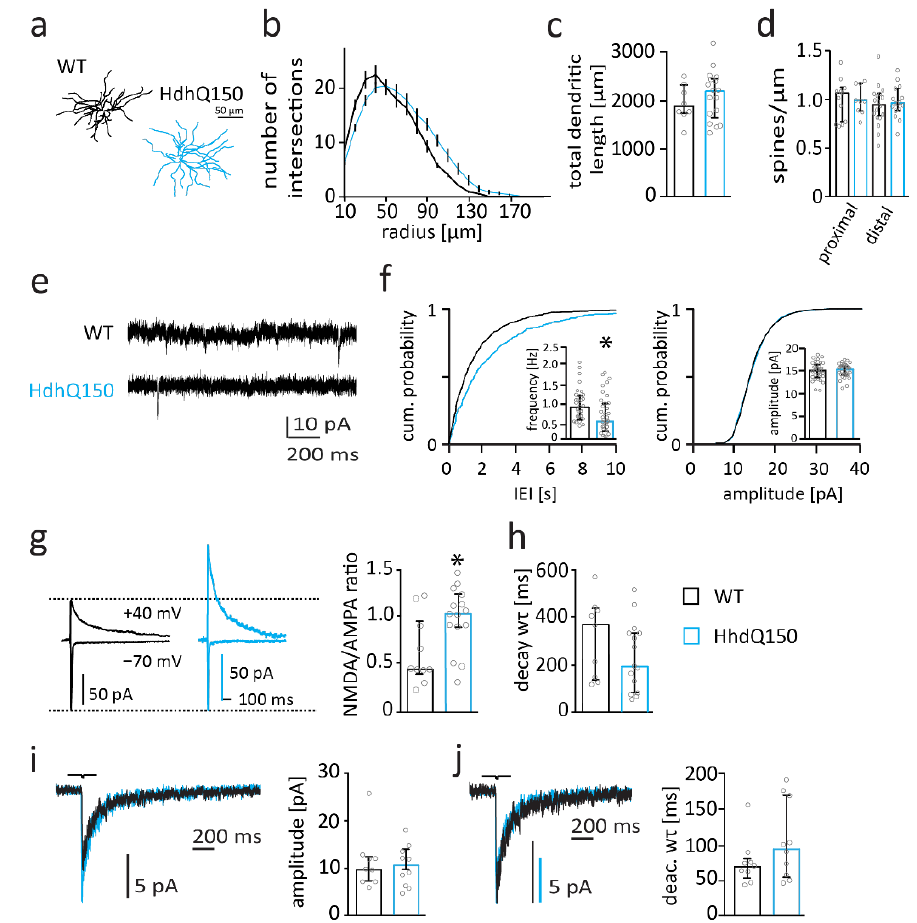
Figure 4. Synaptic function is impaired in 6-month-old HdhQ150/BL6 mice. ( a ) Example reconstruc- tions of MSNS. ( b ) Sholl analysis with number of dendrite intersections per radius and ( c ) bar graph of total dendritic length of MSNs from WT ( n = 8) and HdhQ150/BL6 ( n = 17) mice. ( d ) Bar graph of spine number per µ m of MSNs from WT ( n = 10) and HdhQ150/BL6 ( n = 18) mice. ( e ) Sample traces of mEPSC recordings from MSNs from 6-month-old WT and HdhQ150/BL6 mice. ( f ) Cumu- lative distribution plot of mEPSC IEIs and amplitude as well as bar graphs of the median mEPSC frequency and amplitude of MSNs from 6-month-old WT (black, n = 31) and HdhQ150/BL6 (blue, n = 32) mice. ( g ) Sample traces of NMDAR- and AMPAR-mediated currents recorded at a holding potential of +40 mV and − 70 mV, respectively, and bar graph of the NMDA/AMPA-ratio of MSNs from WT ( n = 10) and HdhQ150/BL6 ( n = 15) mice. ( h ) Bar graph of the time constant (w τ ) of NDMAR-mediated current decay in MSNs of WT ( n = 9) and HdhQ150/BL6 ( n = 15) mice. ( i ) Sample traces of extrasynaptic NMDAR-mediated currents recorded in nucleated patches and bar graph of peak current amplitudes of MSNs from WT ( n = 9) and HdhQ150/BL6 ( n = 10) mice. ( j ) Peak-scaled sample traces of extrasynaptic NMDAR-mediated currents recorded from nucleated patches, and bar graph of the deactivation time constant (w τ ) of currents from MSNs of WT ( n = 9) and HdhQ150/BL6 ( n = 10) mice. Bar graphs are depicted as median ± IQR. * = p <